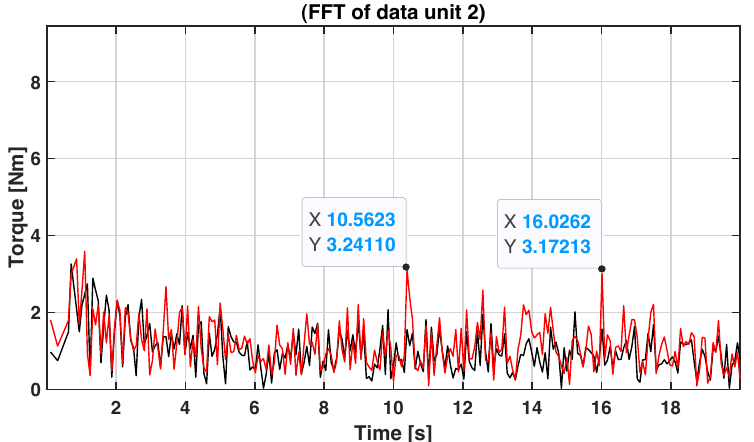
Figure 16. FFT applied to data unit 2 extraction. In black, the FFT of the joint torque under healthy conditions is represented, while in red, it is under faulty conditions.